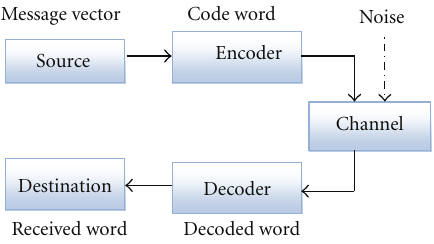
Figure 1: A simplified communication system